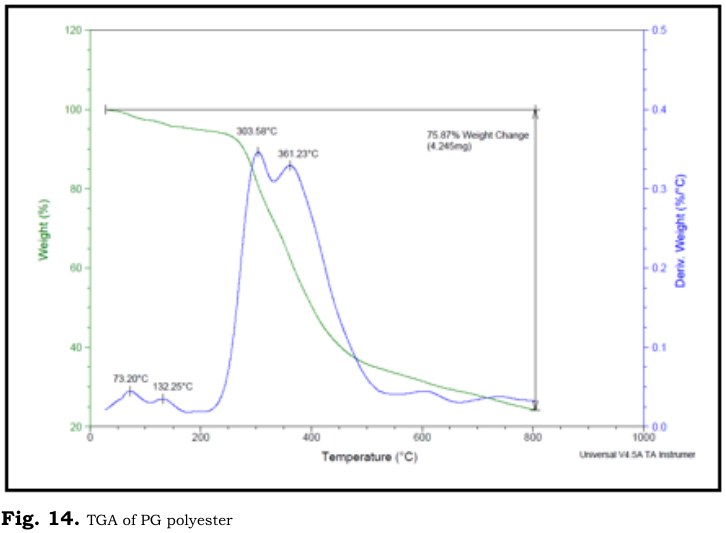
Fig. 14. TGA of PG polyester